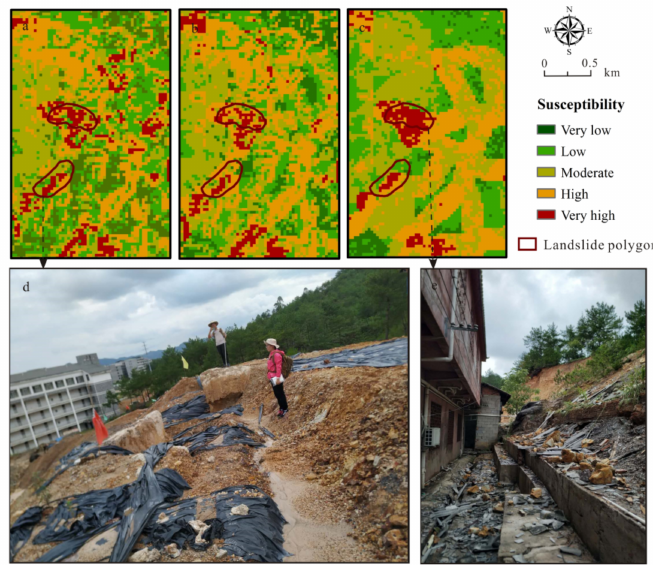
Figure 12. Prediction of the landslide susceptibility and case verification: ( a ) from simple numeric labeling (SNL)-based RF modeling; ( b ) from weight assignment (WA)-based RF modeling; and ( c ) from frequency ratio (FR)-based RF modeling. ( d ) landslide behind the No. 6 Middle School of Ruijin and ( e ) bulges on the side wall feet of the Longzhu